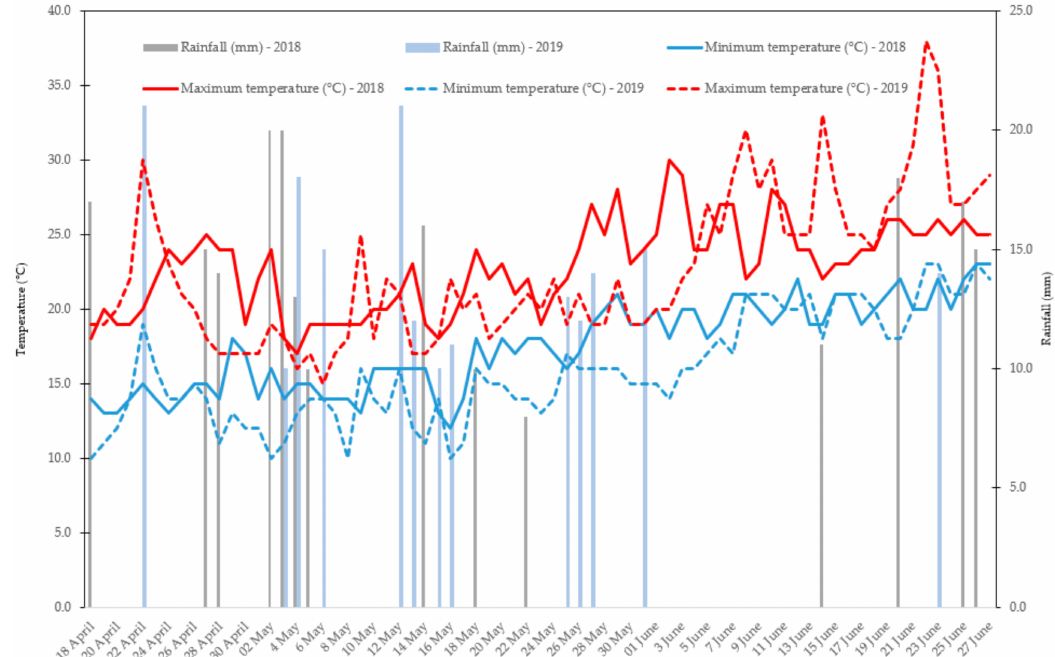
Figure 1. Daily temperature (maximum and minimum) and rainfall from 18 April to 27 June (2018 and 2019).